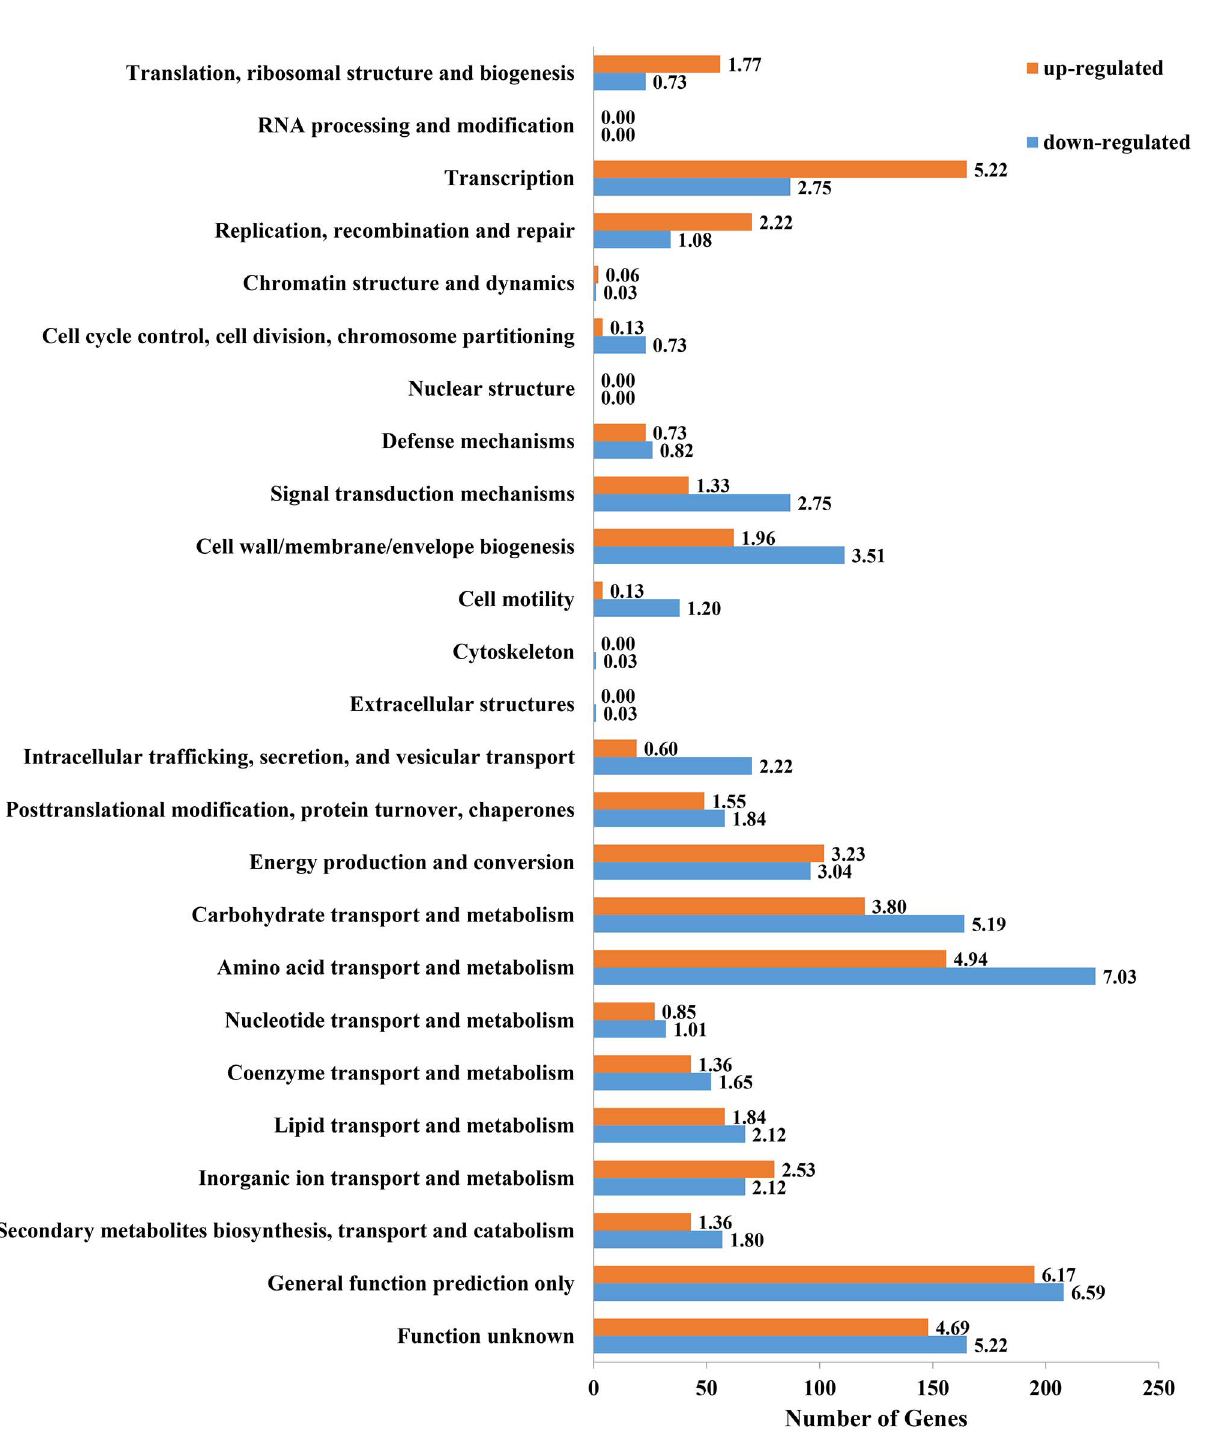
Figure 3. COG functional categories of differentially expressed genes identified by both RNA-Seq and Microarrays. All differentially expressed genes during bacteroids were assigned to the 26 COG functional categories using RPS-BLAST (uncategorized genes not shown). Bars represent the number of up-regulated (orange) and down-regulated (blue) genes in bacteroids compared with free-living cells. The number in each bar represents its up/down-regulated percentage (%).